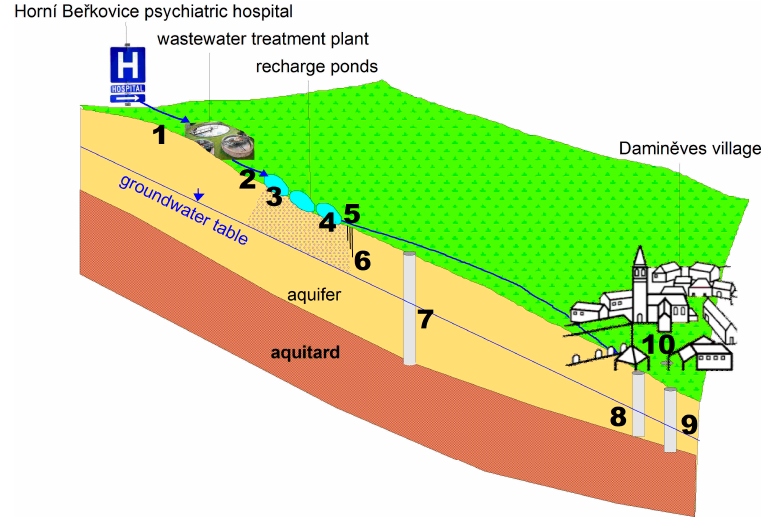
Figure 2. Horní Be ř kovice monitoring scheme. Figure 2. Horn í Beˇrkovice monitoring